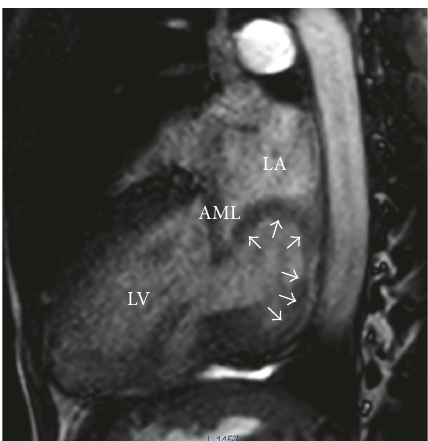
Figure 3: CMR cine run in the sagittal plane reconfirms the thick-walled parachute mass (arrows) tethered to the tip of AML and LA inferoposterior region. Systolic flow into the mass and significant MR are also evident. LA: left atrium, LV: left ventricle, AML: anterior mitral leaflet, and MR: mitral regurgitation.